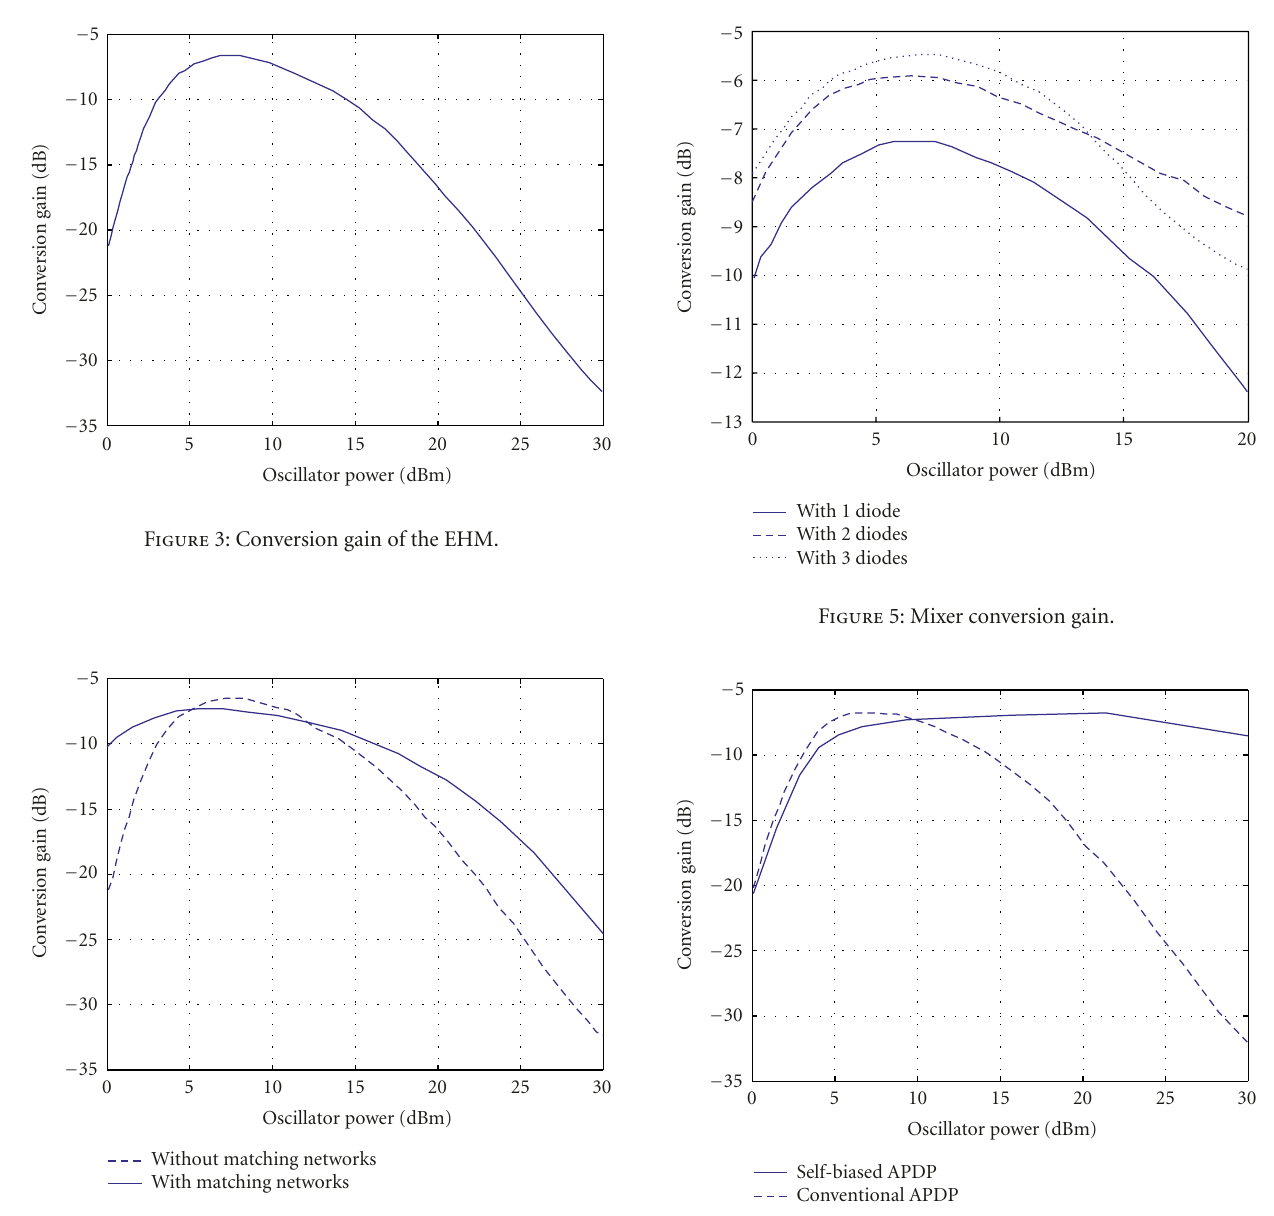
Figure 4: Mixer conversion gain.